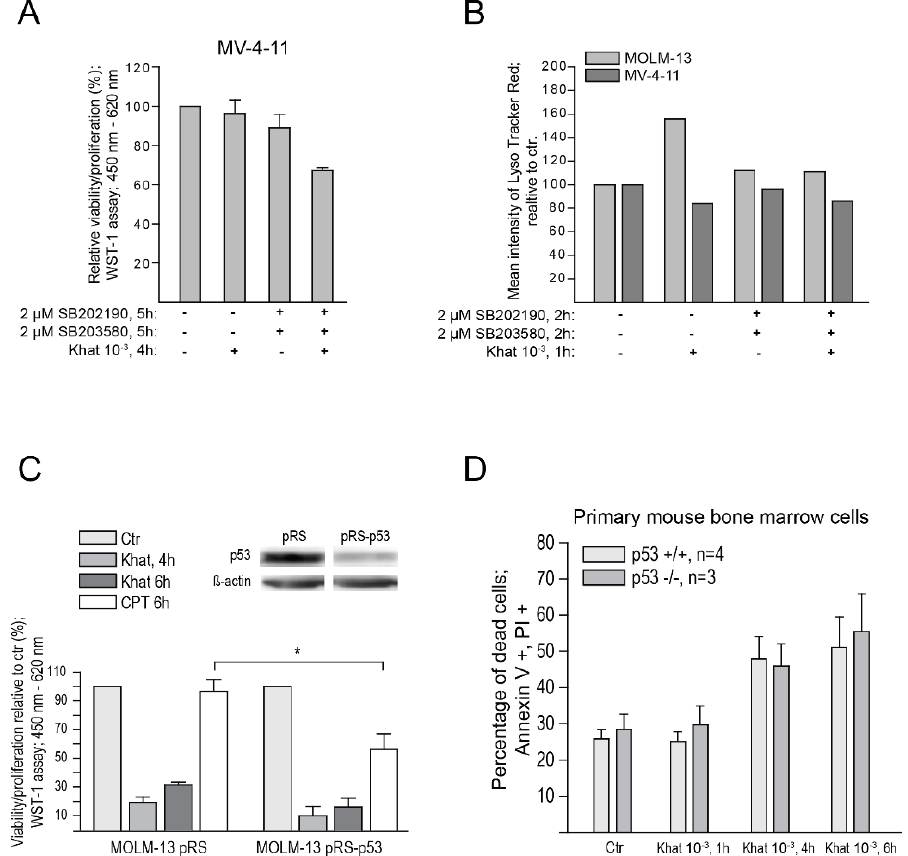
Figure 4. p38 inhibitors sensitized resistant MV-4-11 cells to khat and p53 are not necessary for khat- cytotoxicity. ( A ) MV-4-11 cells were exposed to a khat-extract dilution of 10 – 3 for 4 h and/or pre-treated with p38 inhibitors for 1 h (SB203580, 2 µM, and SB202190,2 µM). Effects on cell viability/proliferation were assessed after 4 h using the WST-1 assay. The results were collected by measuring absorbance (450 – 620 nm) and are presented as: [(absorbance treated cells)/(absorbance control cells)] × 100. ( B )